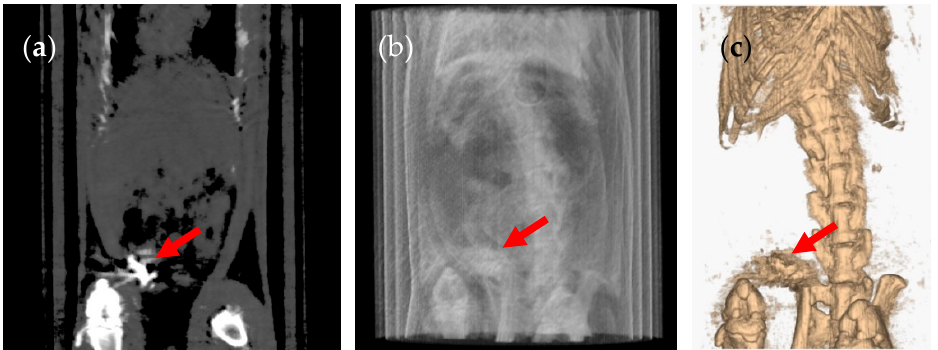
did not receive anaesthesia.